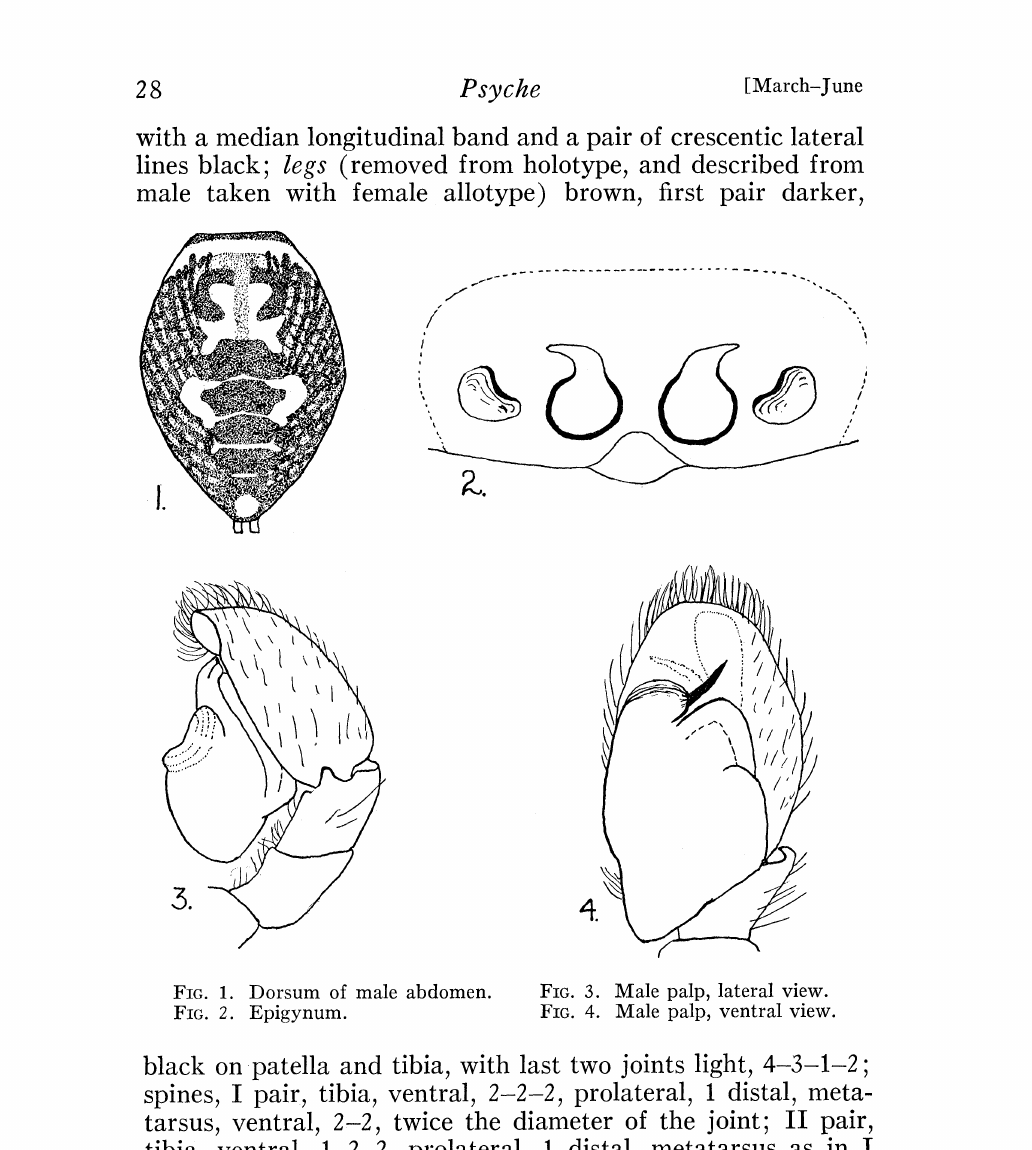
FIG. 1. Dorsum of male abdomen. FIG. 2. Epigynum.